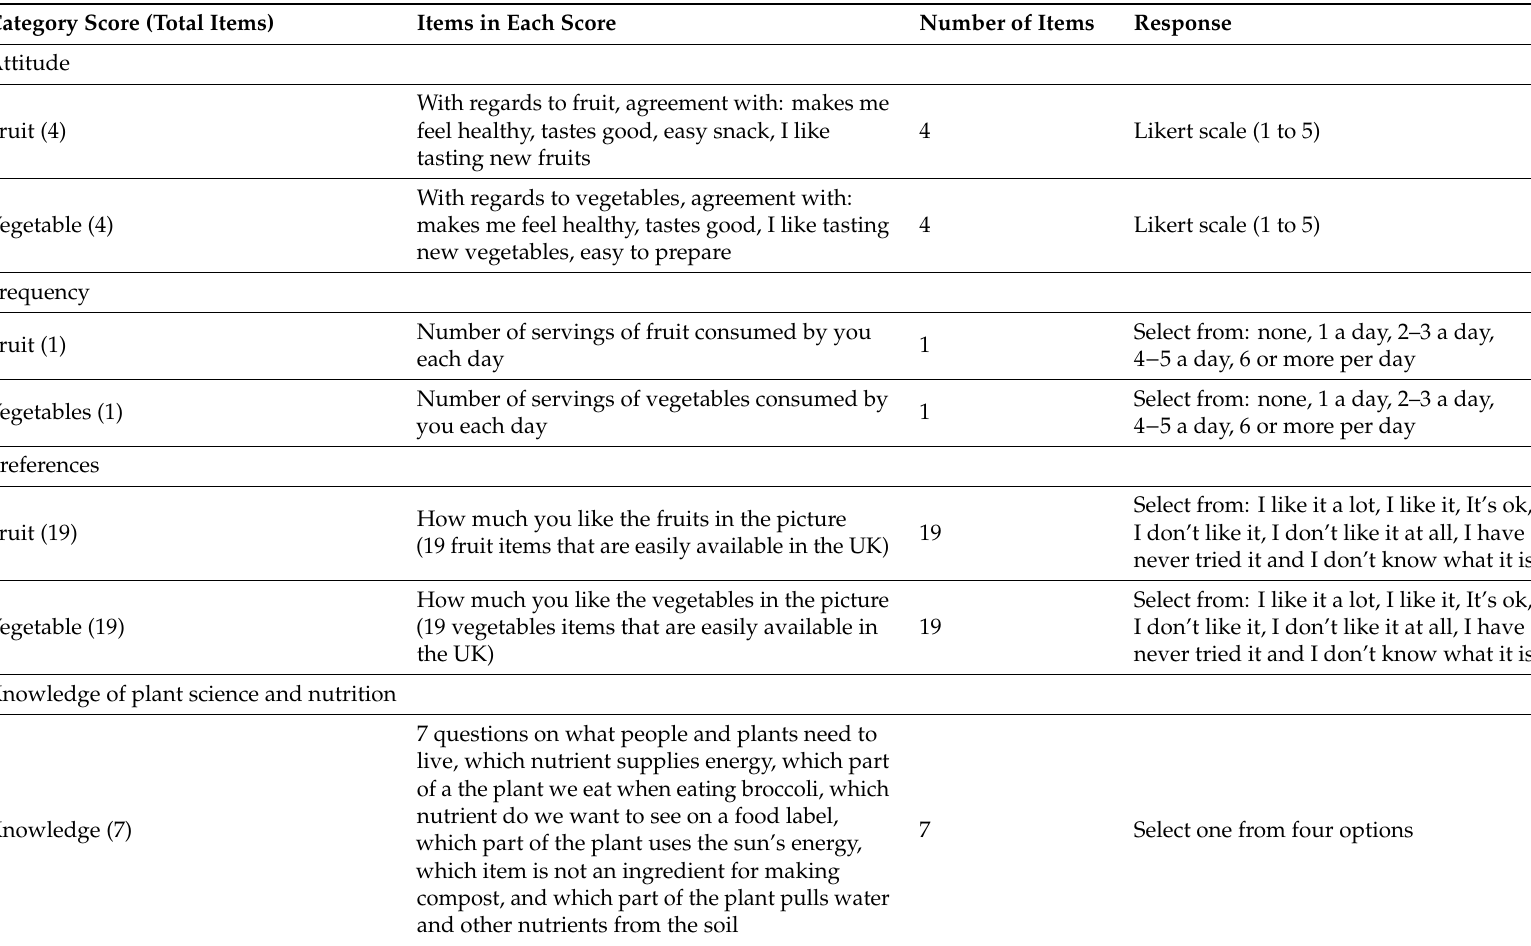
Table 2. Questionnaire items and response